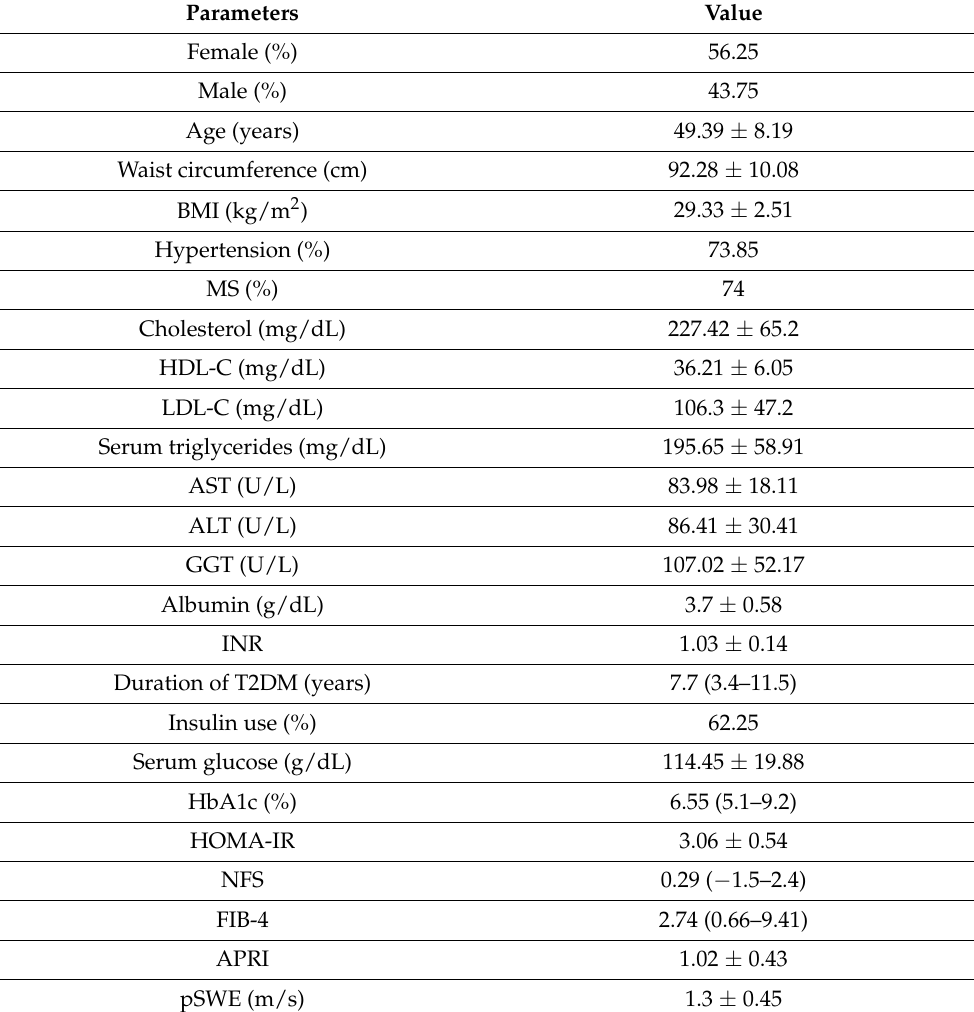
Table 1. Baseline characteristics of the 134 patients with